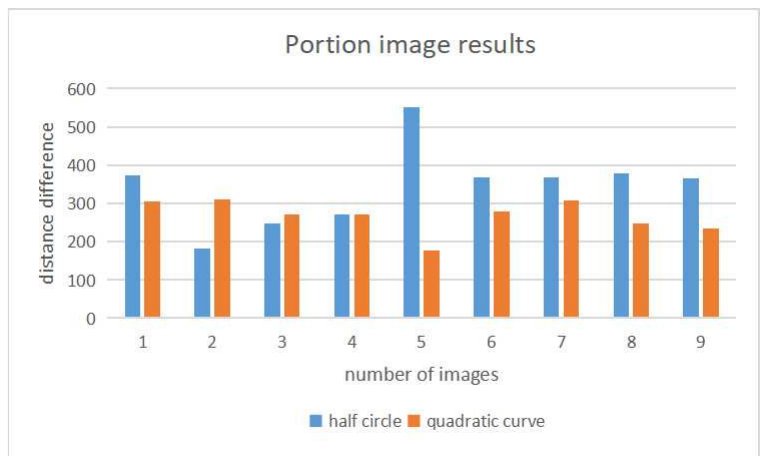
Figure 14. Score comparison between two models after optimization.